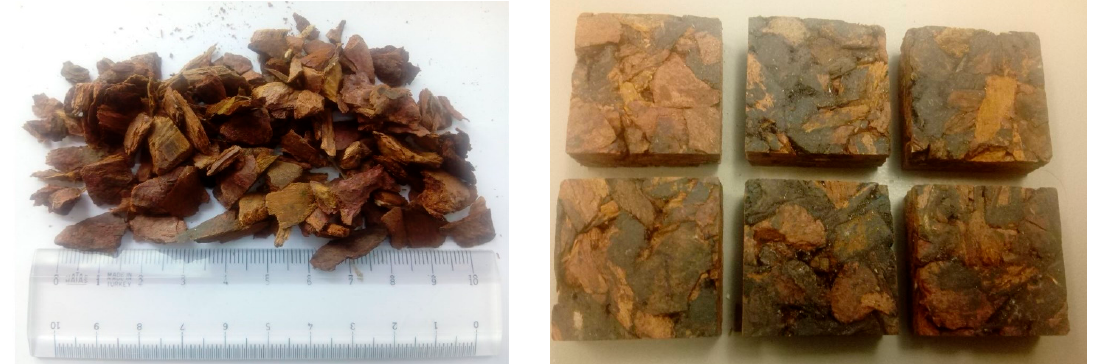
Figure 1. Larch bark particles (8–13 mm) (left) and bark based composite specimens (right) for acoustic measurements.